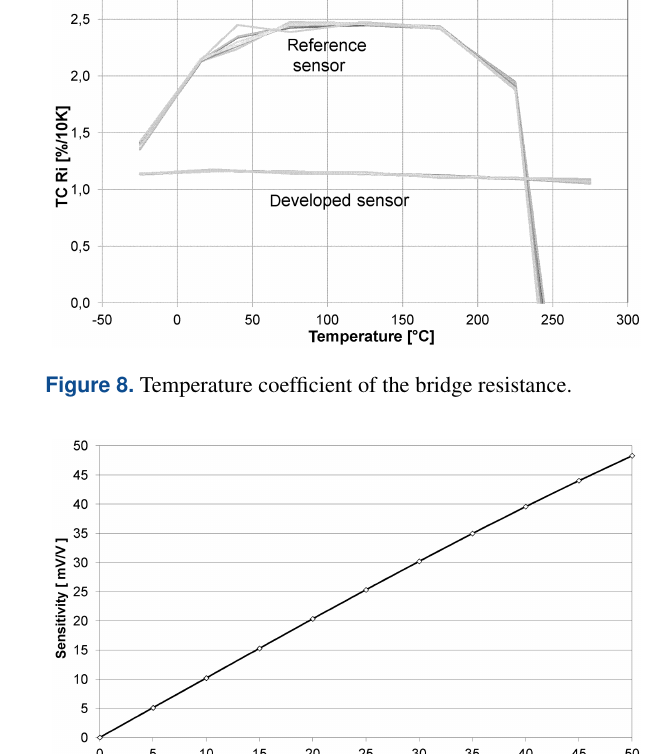
Figure 7. Temperature-dependent leakage currents.